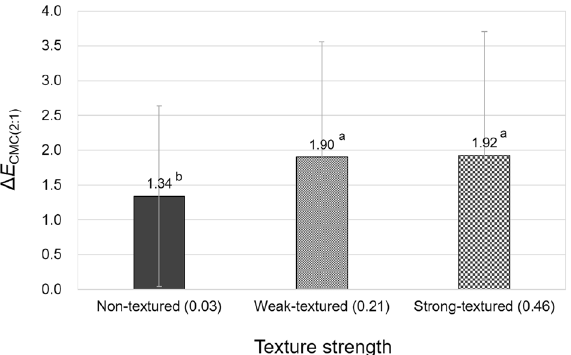
Figure 12. Effect of the texture strength of samples on their overall color appearance change, Δ E CMC(2:1) , under